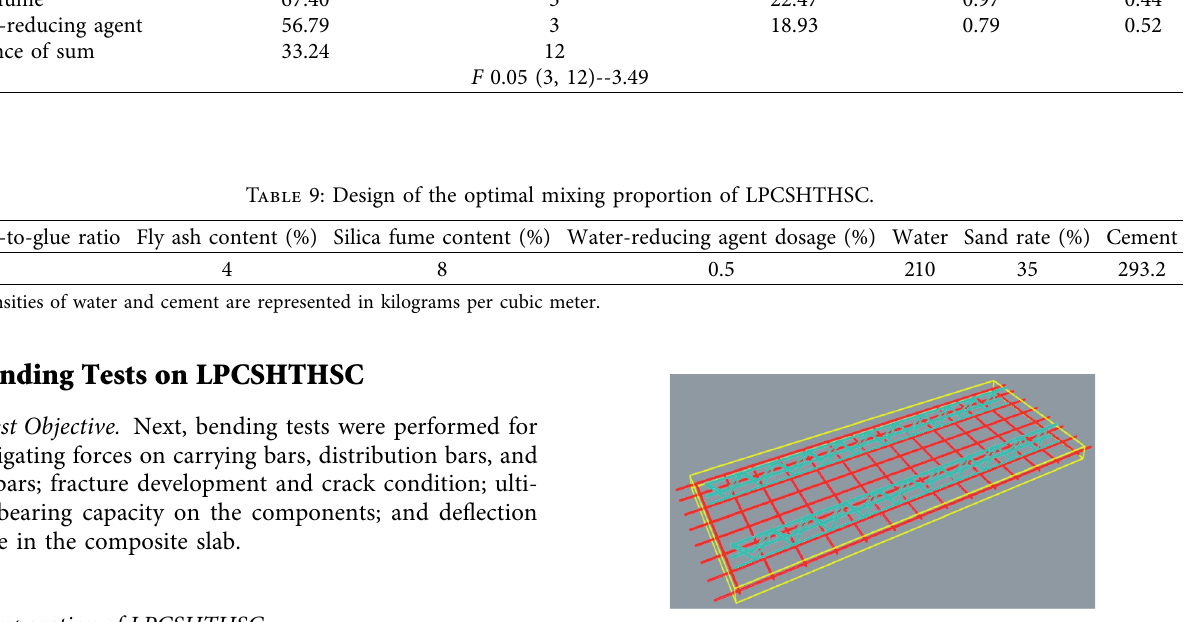
Figure 1: Illustration of LPCSHTHSC